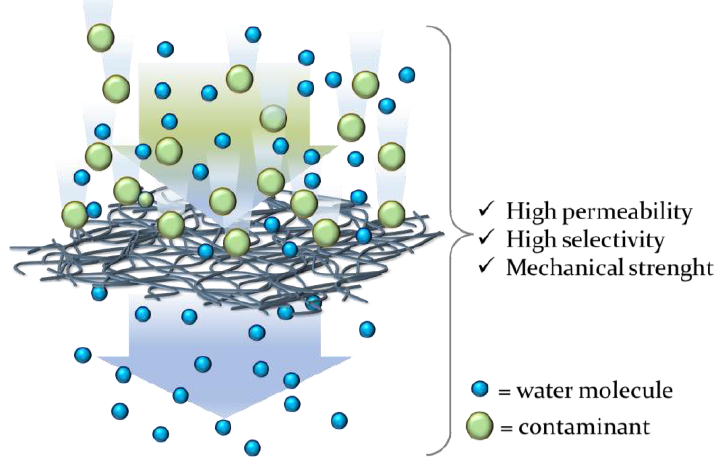
Figure 9. Advantages of nanofiber-based membranes for water filtration.